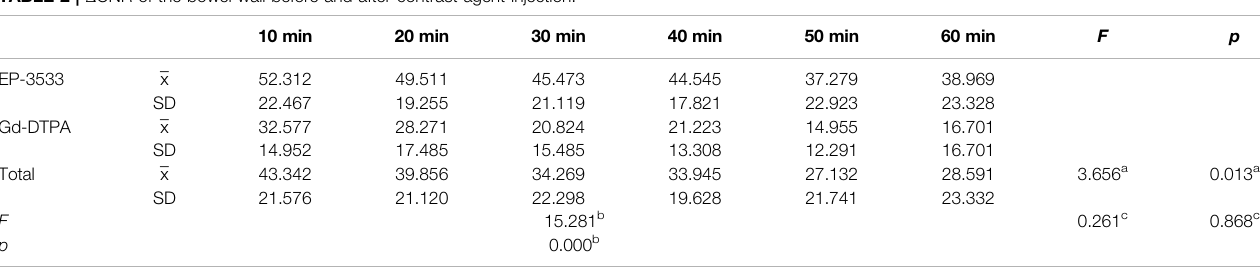
TABLE 2 | Δ CNR of the bowel wall before and after contrast agent